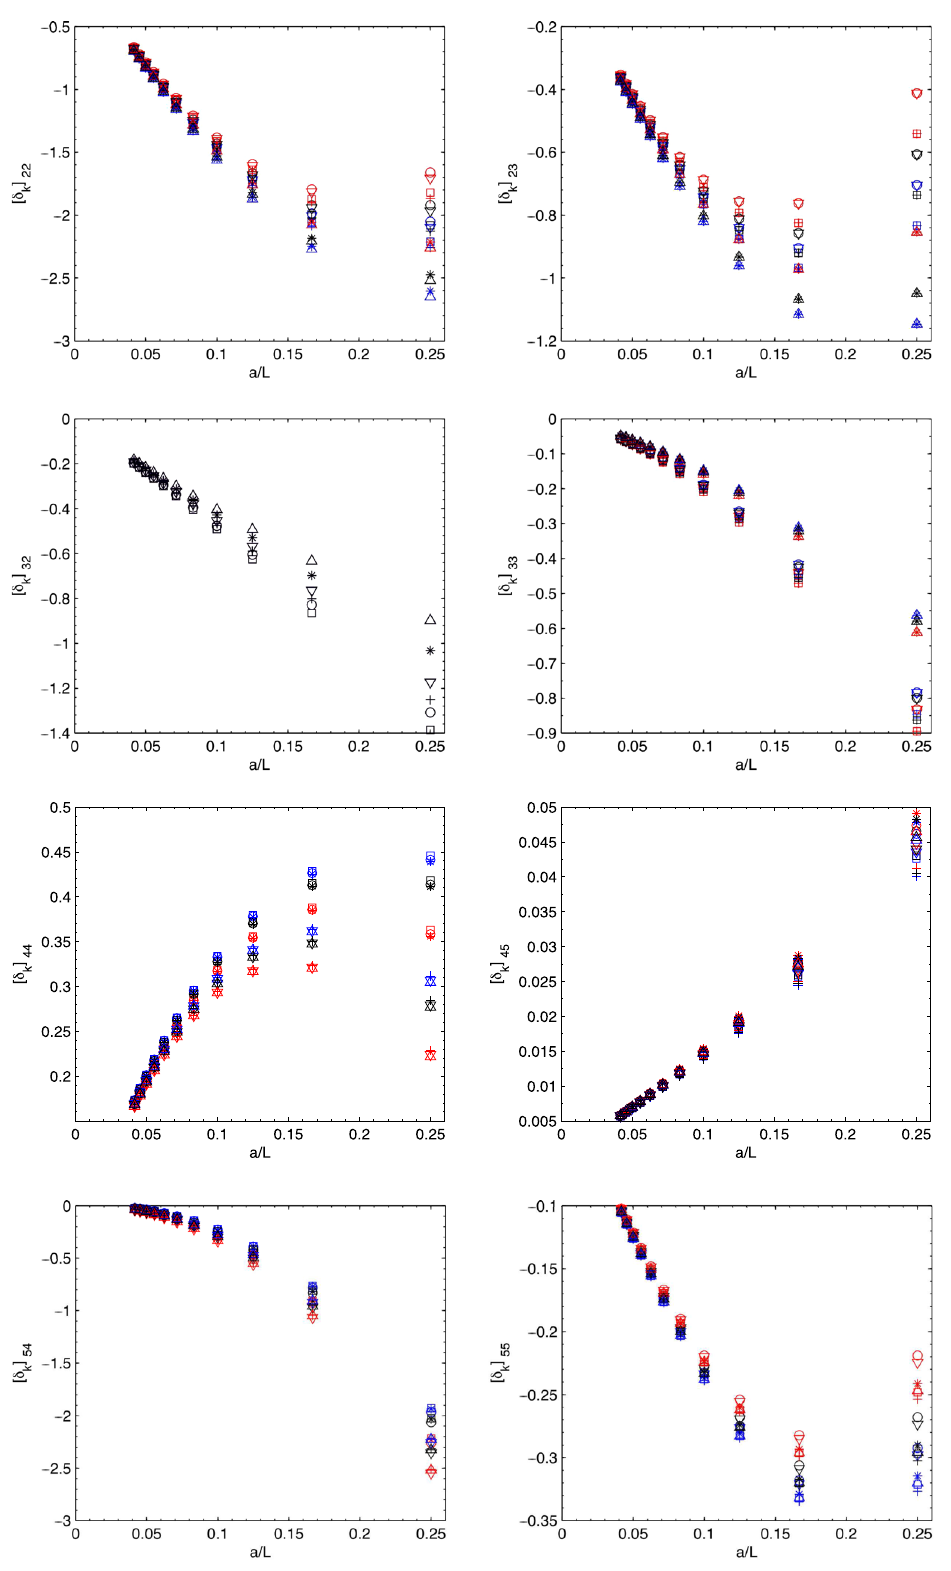
, Q + } (top) and { Q + , Q + } (bottom). Different colours distinguish 2 3 4 5